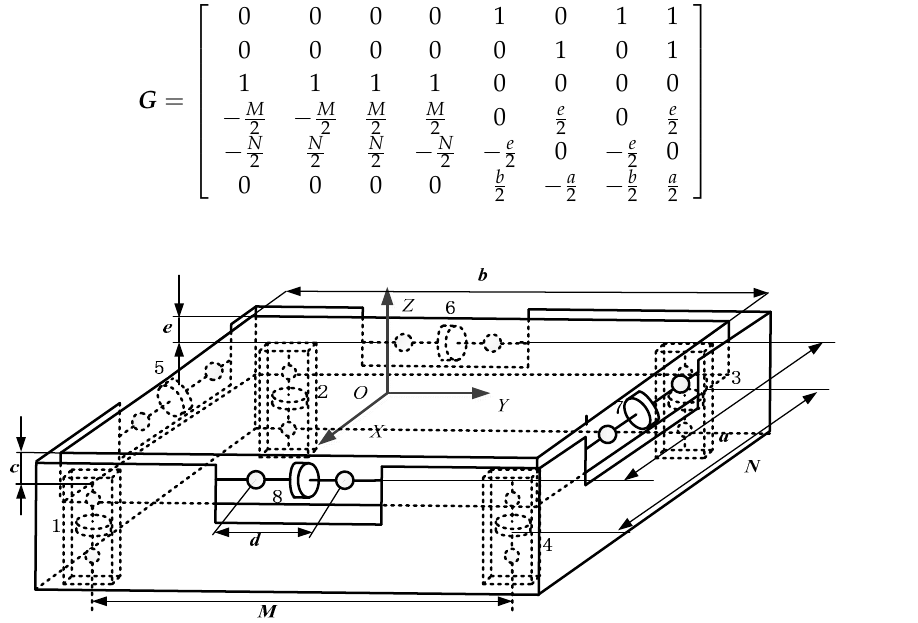
Figure 3. Schematic of the proposed over-constrained six-dimensional force sensor.